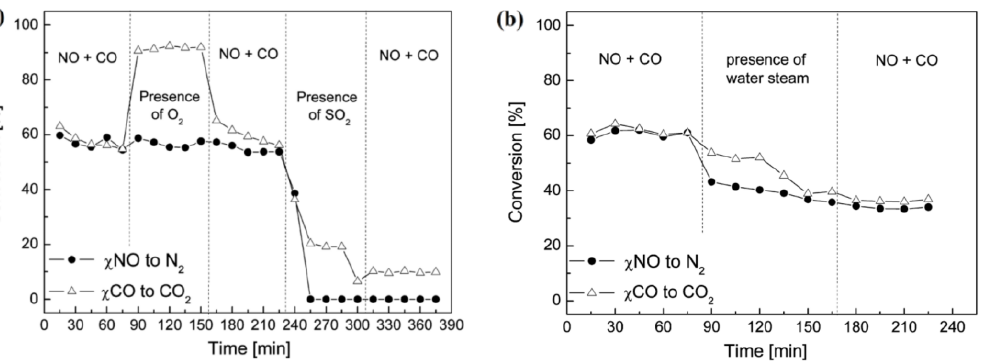
Figure 5. The effect of O 2 or SO 2 ( a ) and H 2 O ( b ) on the catalytic performance for the CO-SCR reaction over Cu/TiO 2 . Reproduced from [26] with tion over Cu/TiO 2 . Reproduced from [26] with permission.